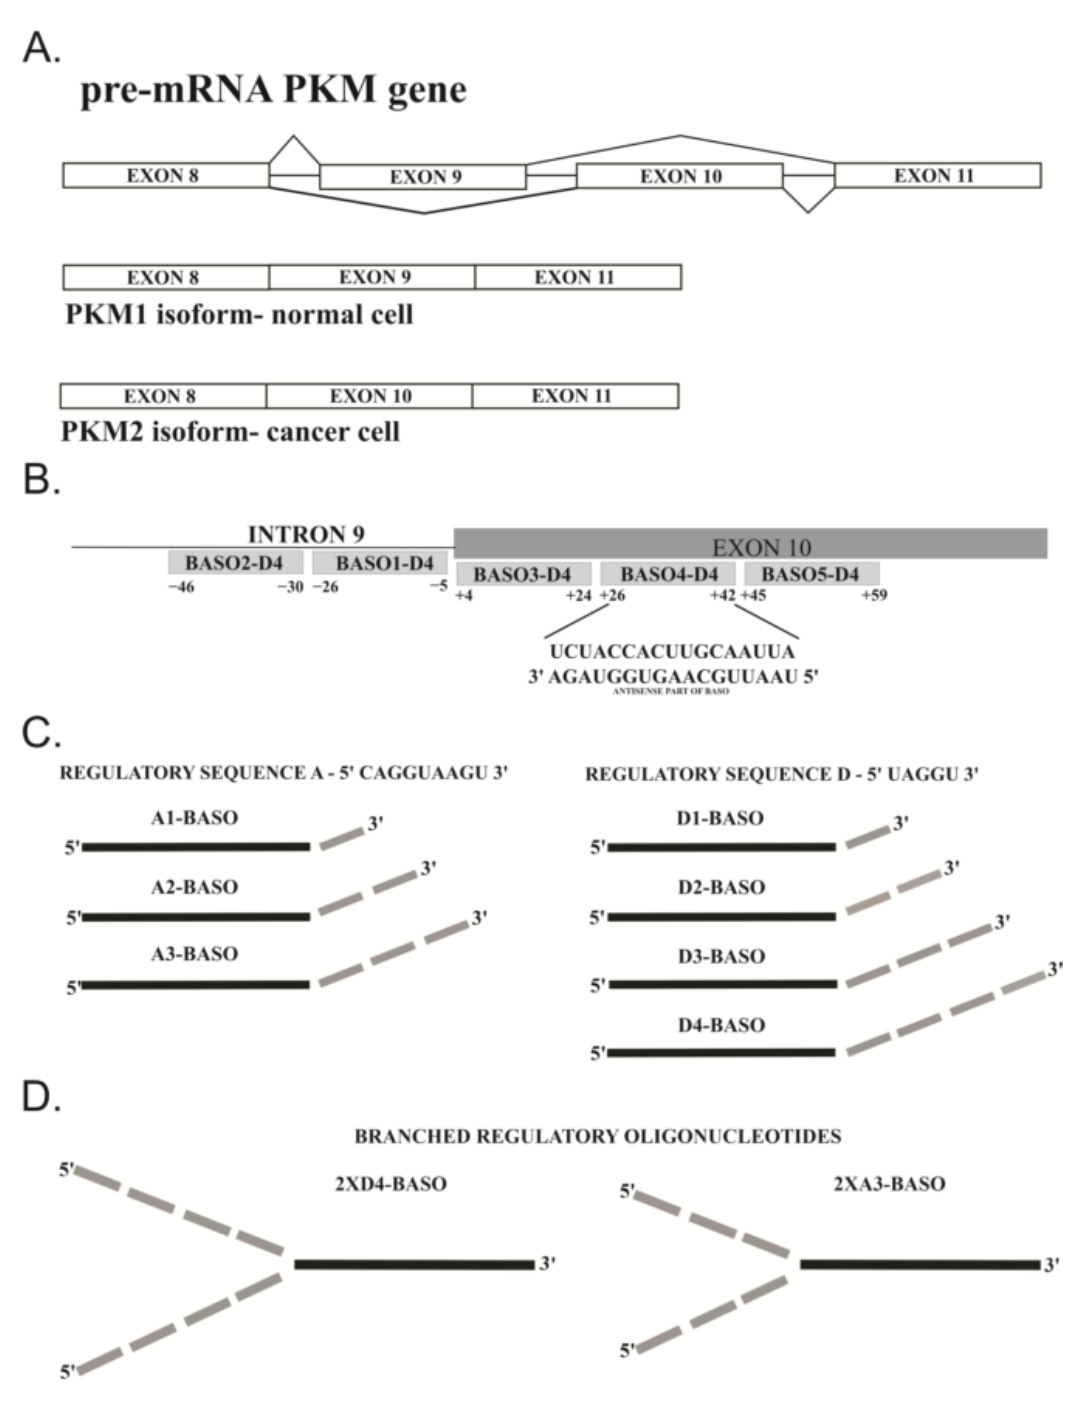
Figure 2. Schematic presentation of ( A ) mutually exclusive alternative splicing of PKM gene; and ( B ) PKM pre-mRNA fragment with different positions of BASOs hybridization via their antisense parts. The underlined letters represent the sequence of pre-mRNA site where the most effective BASO hybridizes. ( C ) Designed BASOs. Black rectangle represents antisense part of constant sequence that hybridizes at position +26 to position +42 of exon 10. The various regulatory parts (A1–A3 and D1–D4) are located at the 3 ′ end of antisense sequence (grey rectangles) and are not involved in the interactions with pre-mRNA. ( D ) The structure of branched BASO. Two regulatory sequences are linked with 5 ′ end of the antisense sequence.